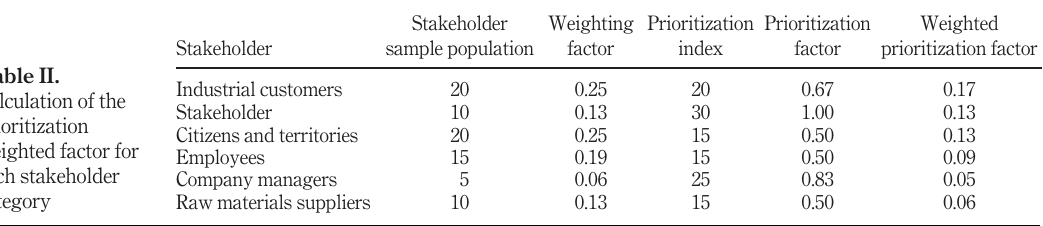
Table II. Calculation of the prioritization weighted factor for each